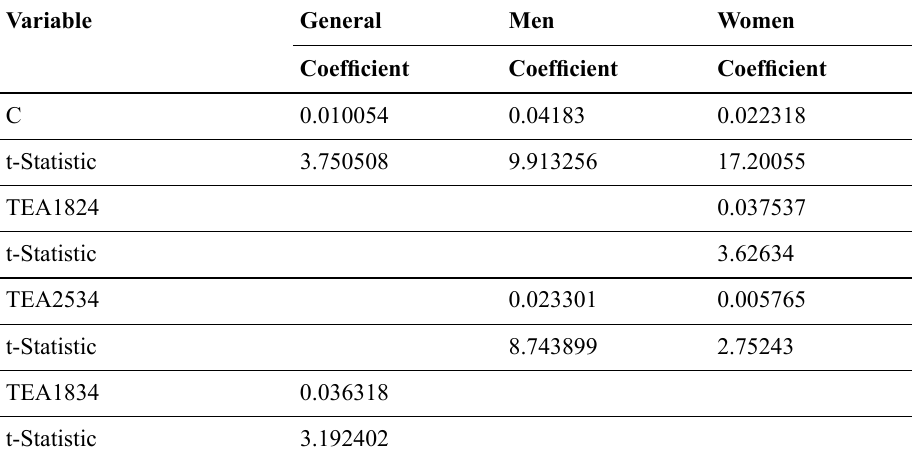
Table 3. Estimations obtained in the general, male, and female models: